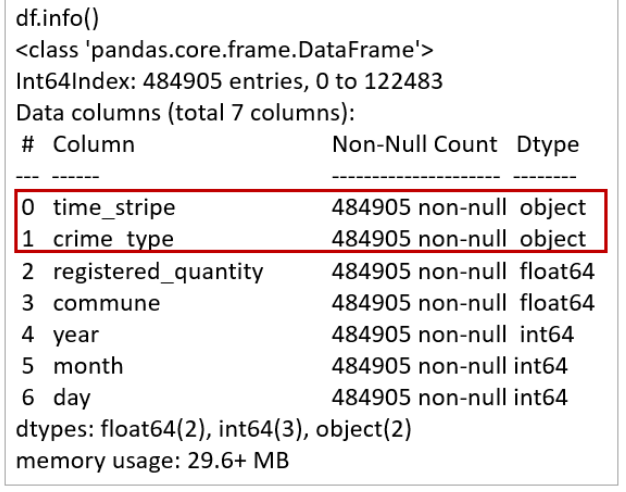
Figure A3. Data frame before and after the consolidation process Source Own elaboration.